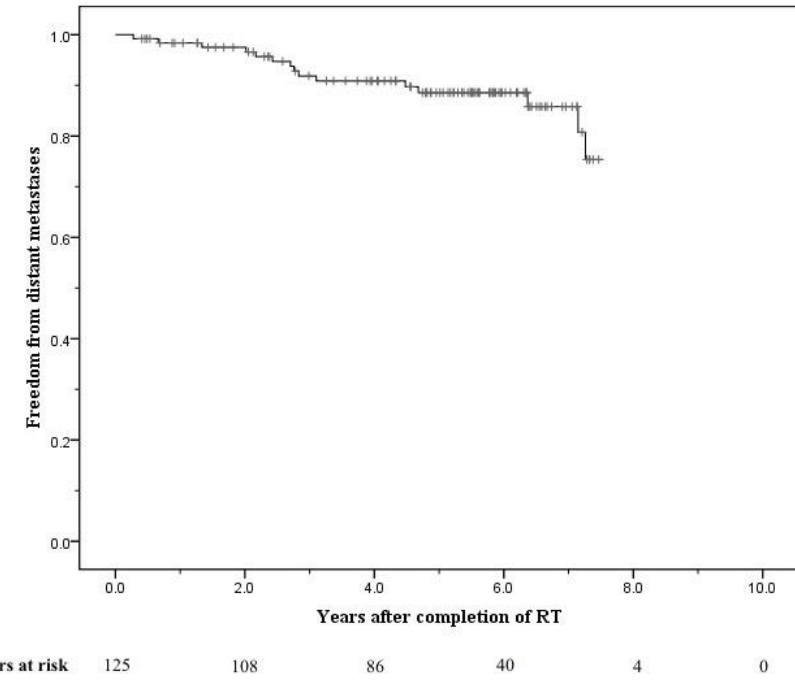
Figure 6. Freedom from distant metastases for the entire cohort.